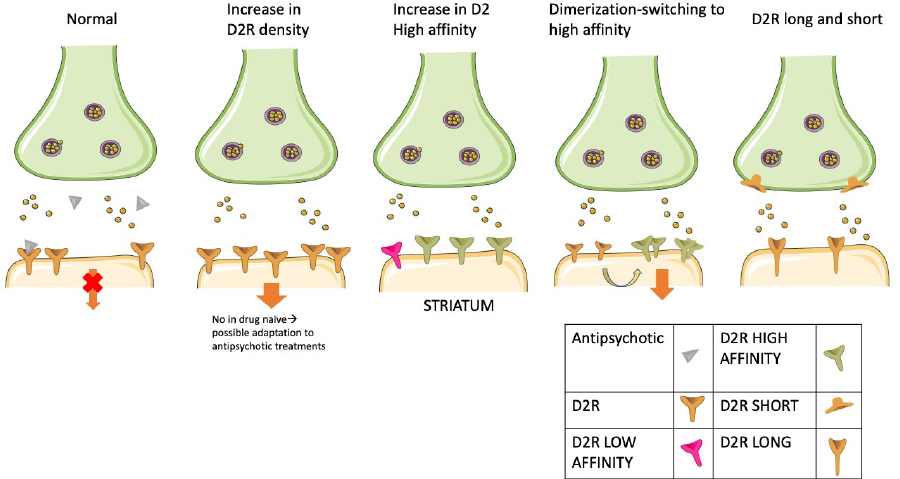
Figure 2. Putative dopamine D2 receptor (D2R)-mediated molecular mechanisms of treatment resistance. The figure illustrates some of the most widely studied putative mechanisms of resistance to antipsychotics associated with D2R dysfunctions. From left to right: (1) dopaminergic synapse in a condition of complete response to antipsychotics. Antipsychotic molecules occupy and block most postsynaptic D2Rs, thus hampering downstream signaling; (2) increase of postsynaptic D2R density. The antipsychotic fails to block a sufficient proportion of D2Rs. Downstream signaling is allowed despite antipsychotic molecules in the synapse. This mechanism has not been observed in drug naïve patients, which may be a consequence of the treatment; (3) a high proportion of receptors is in a high-affinity state, increasing receptor affinity to endogenous dopamine, which competes with and overcomes antipsychotic molecules to bind D2Rs. As a result, antipsychotics fail in antagonizing the D2R-mediated downstream signaling pathway; (4) D2R homodimerization, which fosters the molecular switch from low to D2R high-affinity state, recapitulating the conditions described in point 3; (5) imbalance between the expression levels of the autoinhibitory presynaptic short D2R isoform (D2Short) and of the postsynaptic long D2R isoform (D2Long). Low expression of D2Short or a ratio shift toward D2Long isoforms causes the inability to stop dopamine overload in the synapse.